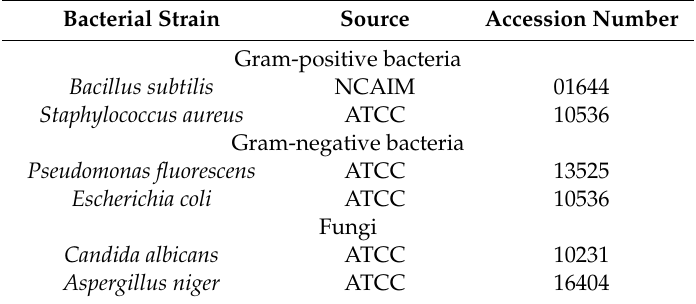
(Table 1). Microorganisms were obtained from American Type Culture Collection (ATCC) and National Collection of Agricultural and Industrial Microorganisms (NCAIM). All strains were stored in cryobanks. Table 1. Microorganisms used in the study. NCAIM, National Collection of Agricultural and Industrial Microorganisms; ATCC, American Type Culture